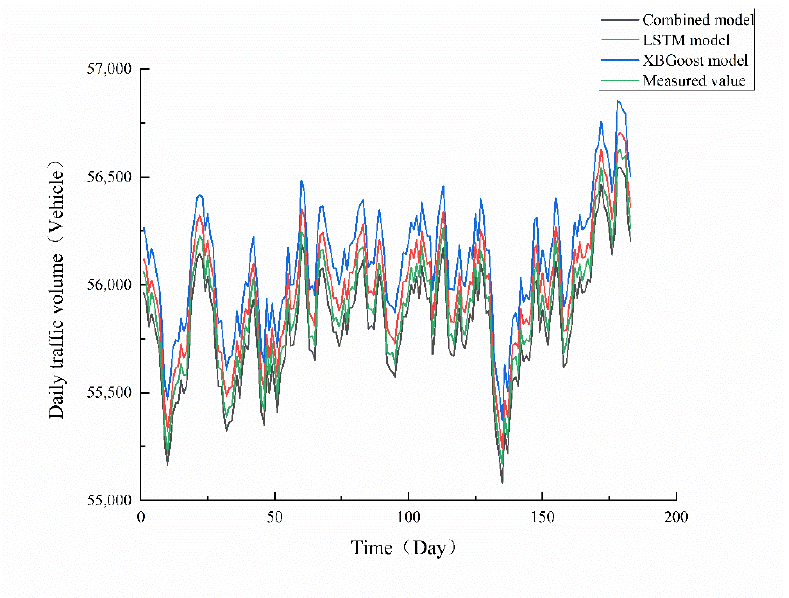
Figure 3. A comparison of prediction results for test set data.